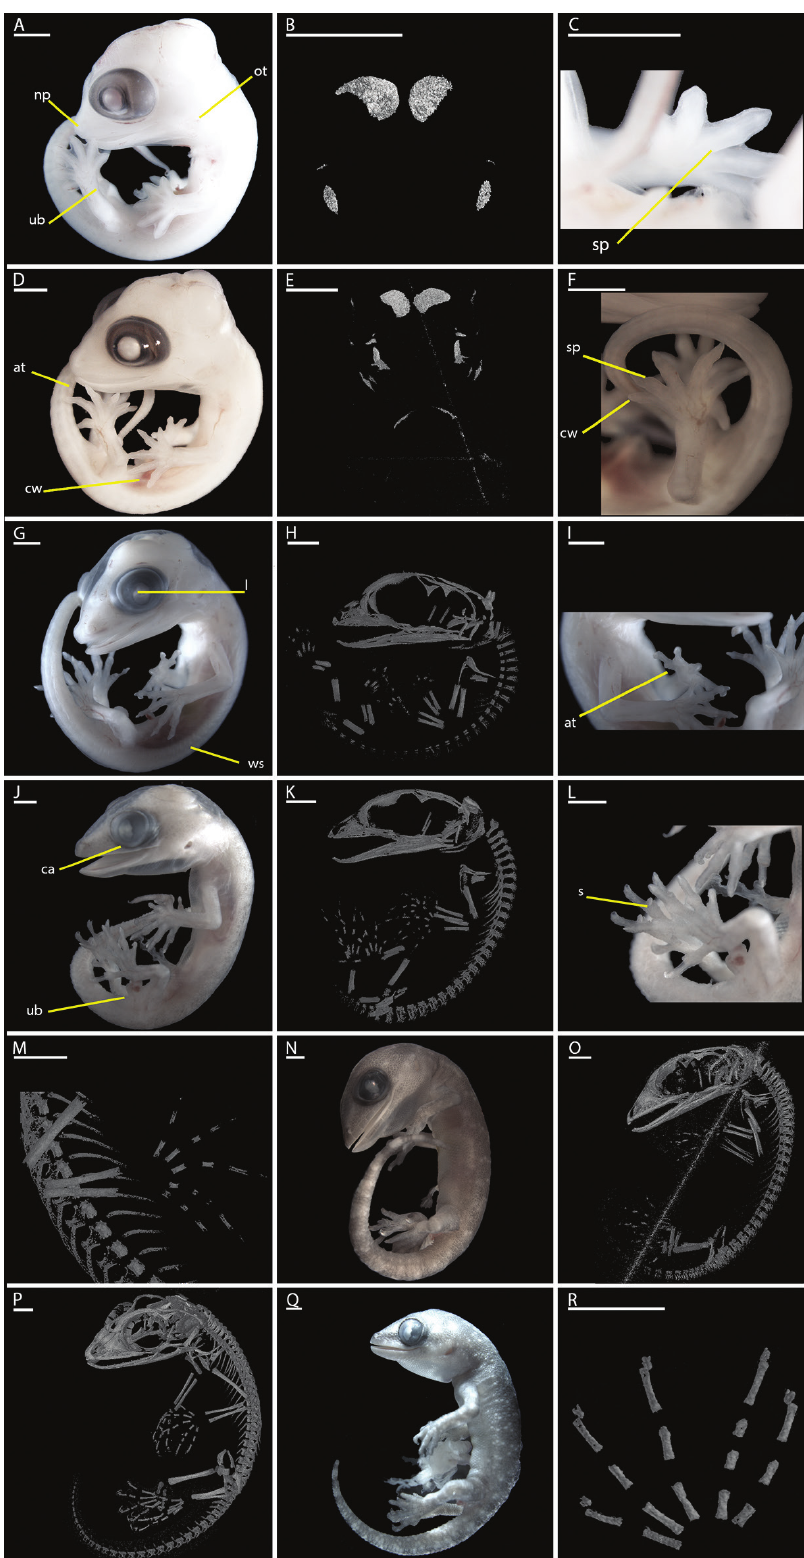
Figure 3. Overview of embryonic developmental stages G to L, erected in this study, including µ CT data. Stage G is shown in (A–C) , its representative is CA2017_004. CA2017_011 represents stage H in (D–F) . (G–I) show stage I represented by CA2017_014. Stage J is depicted in (J–M) , represented by CA2017_008. Stage K is CA2017_013 and shown in (N, O) . (P–R) show CA2017_002 for stage L. (B) and (E) are in cranial view, (R) in dorsal view, and all others in lateral view. Scale bars equal 1mm. Abbreviations: at – adhe- sive toepads; ca – cornea; cw – claw formation; l – lens; np – nose pit; ot – otic capsule; s – scansors; sp – swollen pads; ub – urogenital bud; ws – wrinkly